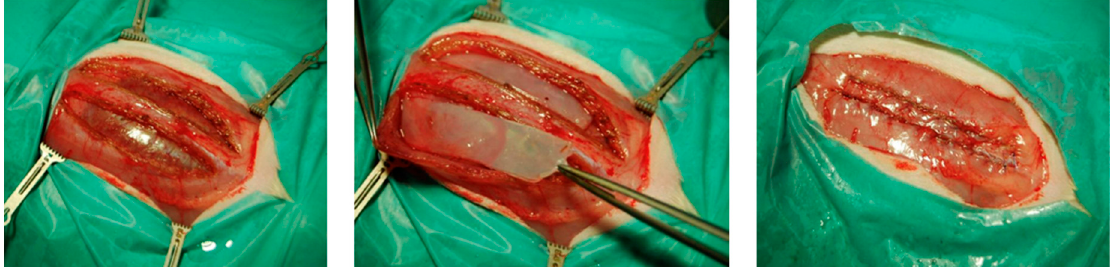
Figure 1. Intraoperative images of the sublay model: Left —Preparation of both rectus sheaths. Middle —Placement of the biocellulose patches. Right —Fascia closure.